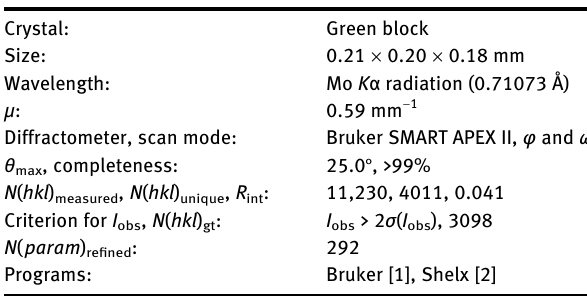
Table  : Data collection and